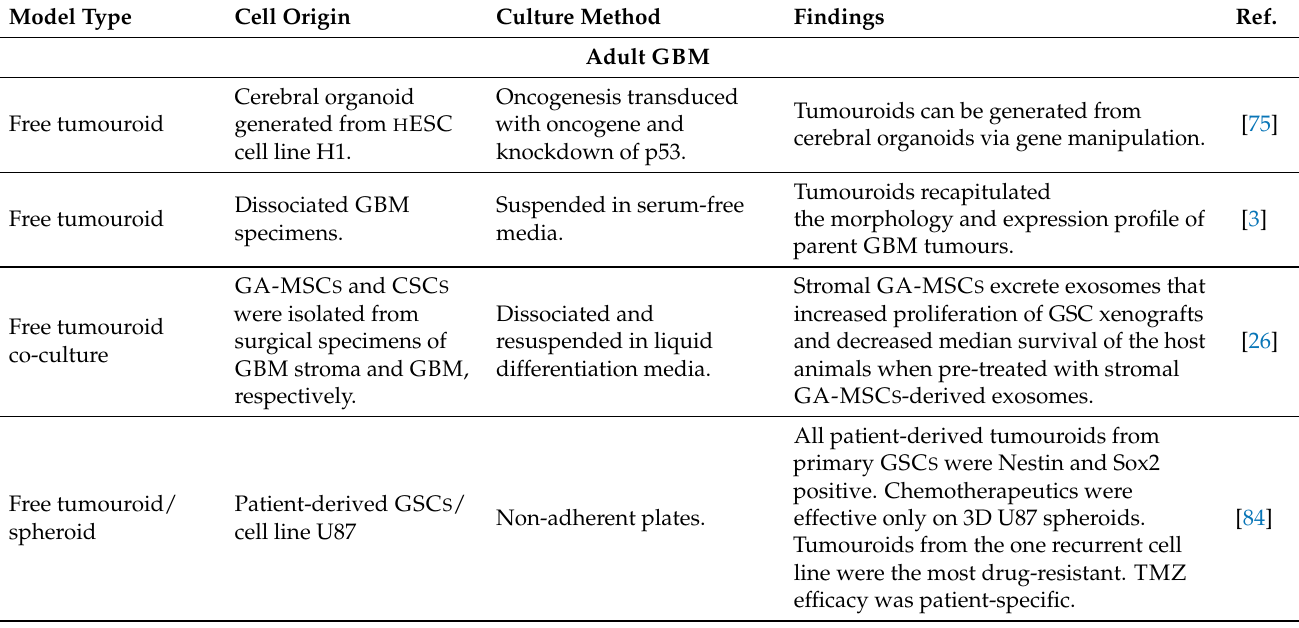
Table 3. Key methods for the formation of free tumouroids and the findings generated with their use. Model